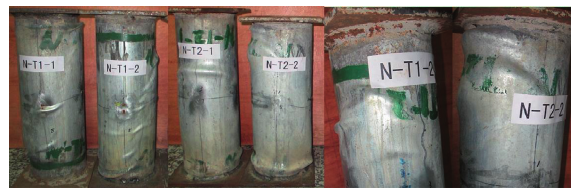
Figure 5: Failure modes of